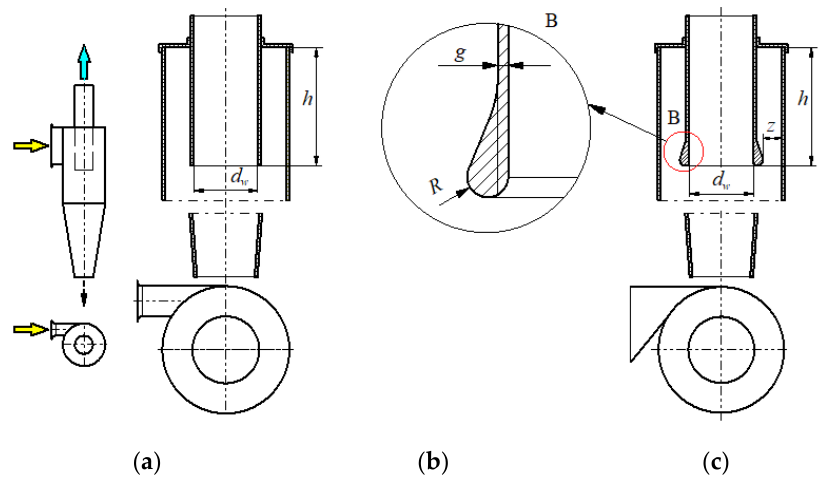
Figure 27. Modification of D -40 cyclone design—Version W2: ( a ) original cyclone version, ( b ) modification component B and ( c ) modification A + B.